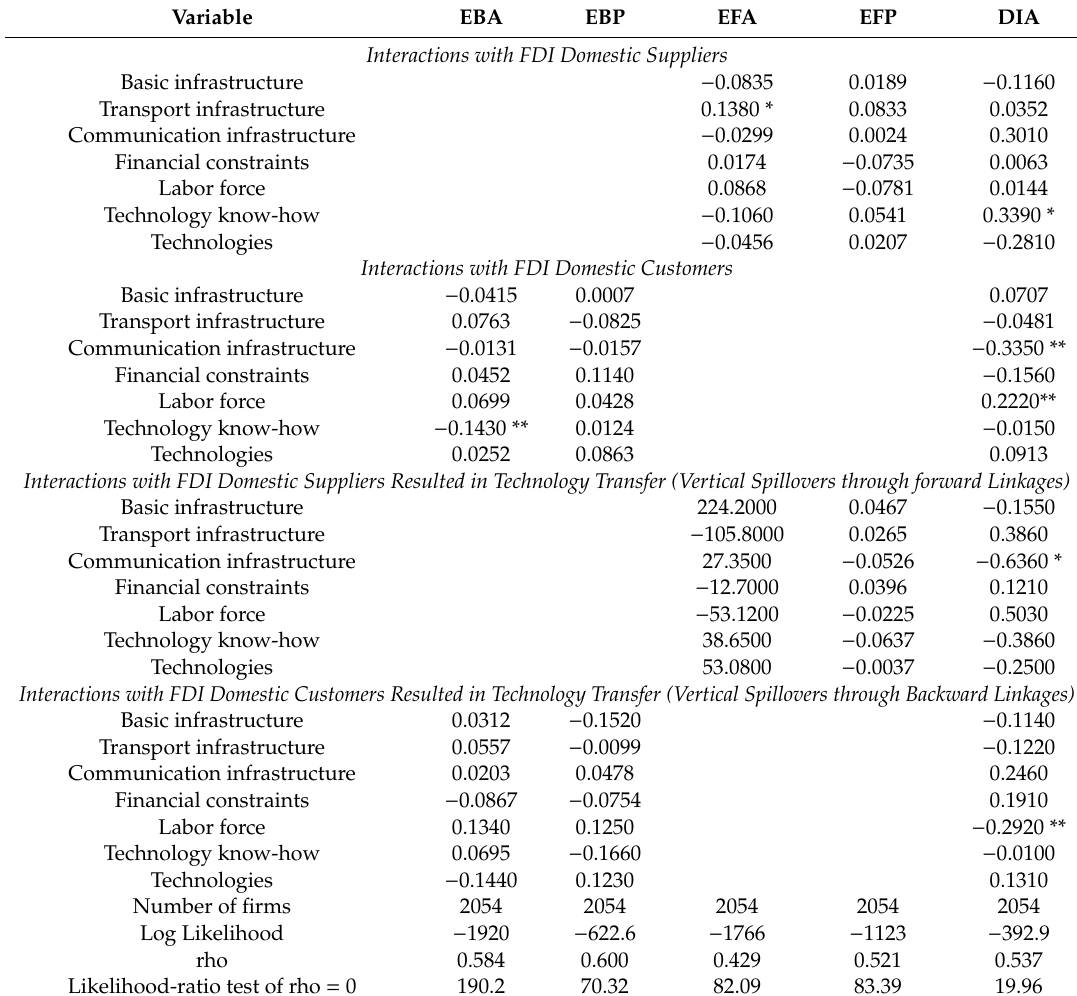
Table 6. Impact of interactions between constraints and FDI linkage and vertical spillovers (marginal e ff ect),